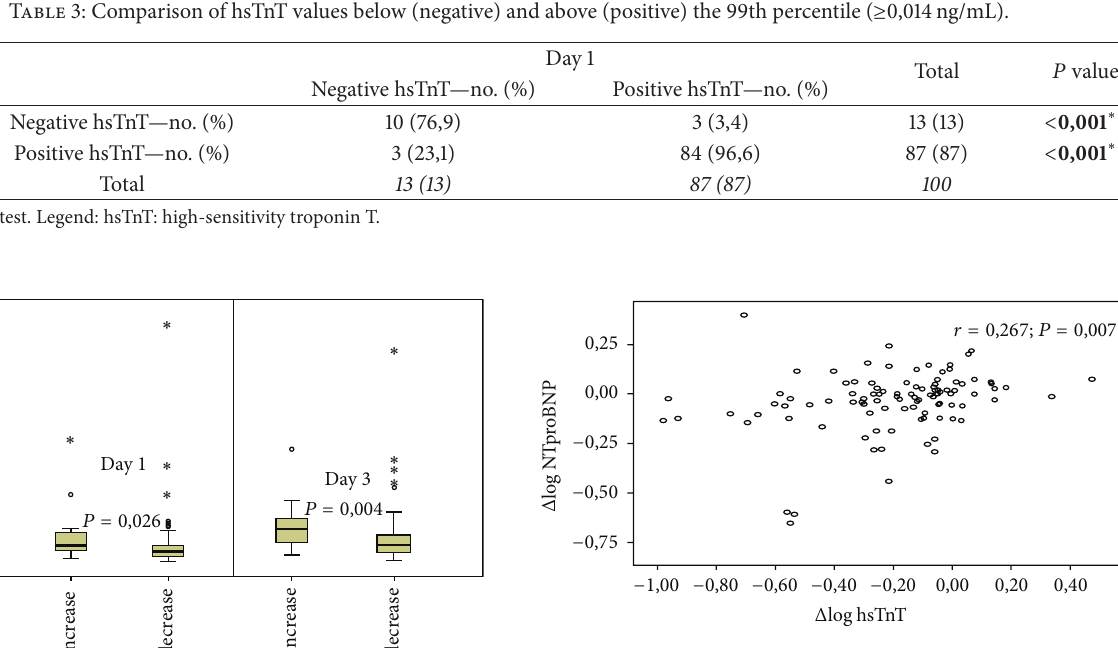
𝑃 value within group 0,955 ∗ 0,025 ∗